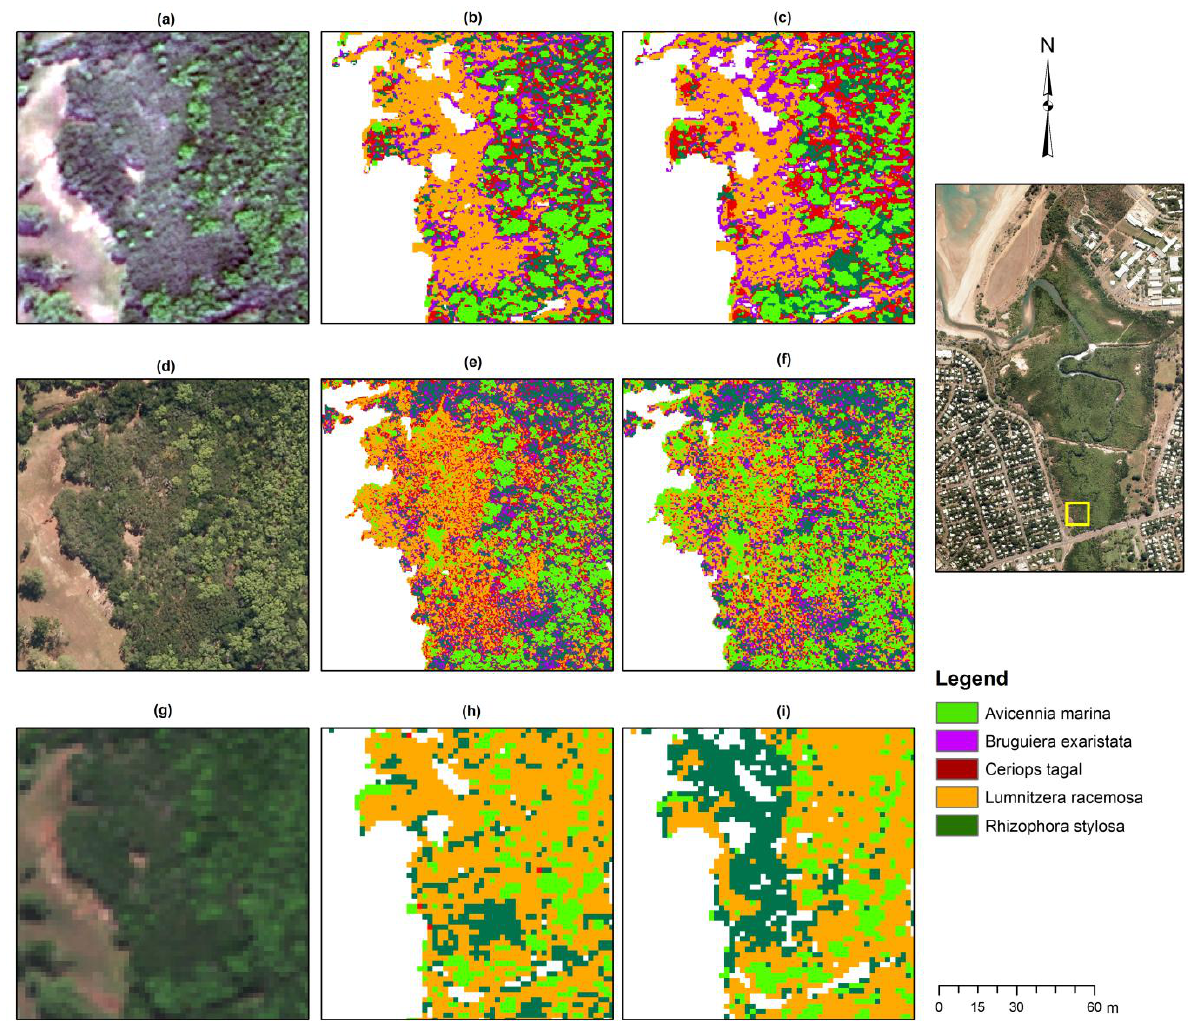
Figure 7. The comparison of the WorldView2 image and different classification approaches: ( a ) Pan-sharpened WV2 image; ( b ) Classification results of PS-WV2-VIS; ( c ) Classification results of PS-WV2-R/NIR1; ( d ) Aerial photograph; ( e )